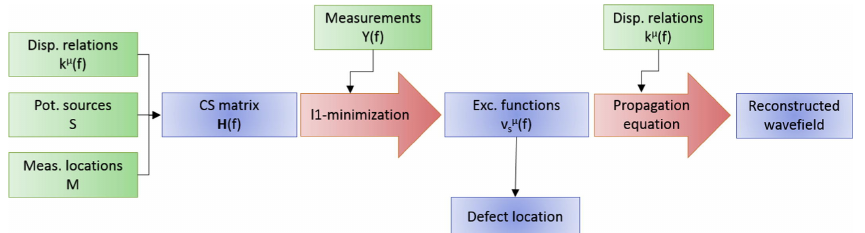
Figure 10. Sparse reconstruction process of wavefield based on CS